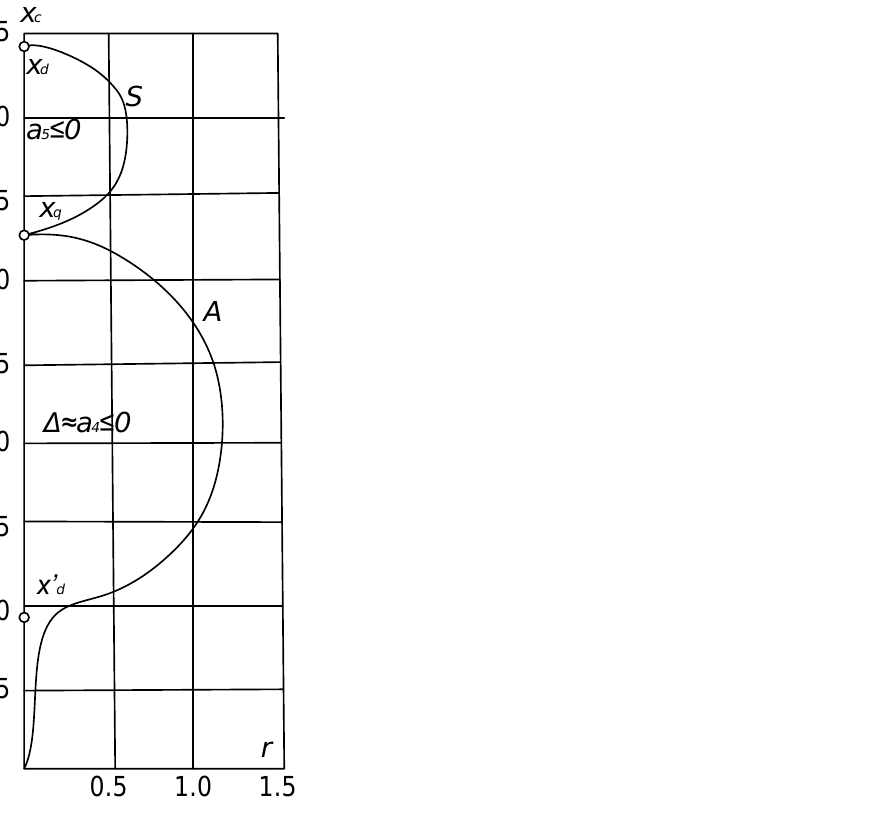
r Figure 2. Partition of the plane , c x into zones of instability (three-phase, salient pole generator, Figure 2. Partition of the plane r , x c into zones of instability (three-phase, salient pole generator, = 0.95, x q = 3.29, x = 4.46, ρ ≈ 10 − 3 ). S is the border of synchronous self-excitation; A is the ' x (cid:48) d d border of asynchronous